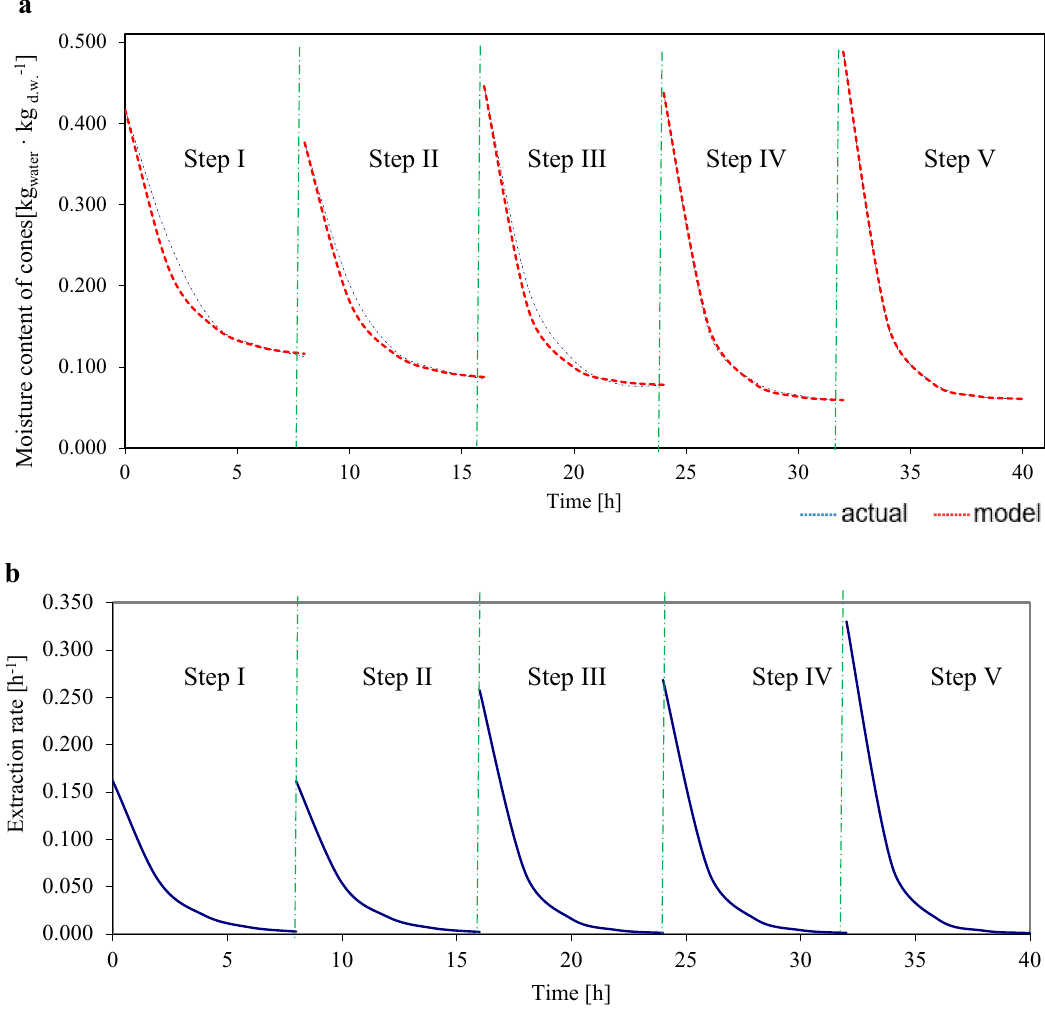
Figure 3. Diagrams: ( a ) actual and predicted changes in cone moisture content, ( b ) extraction rate in five extraction steps for larch cone no. 17 in the 8 h_15 min variant throughout effective extraction.